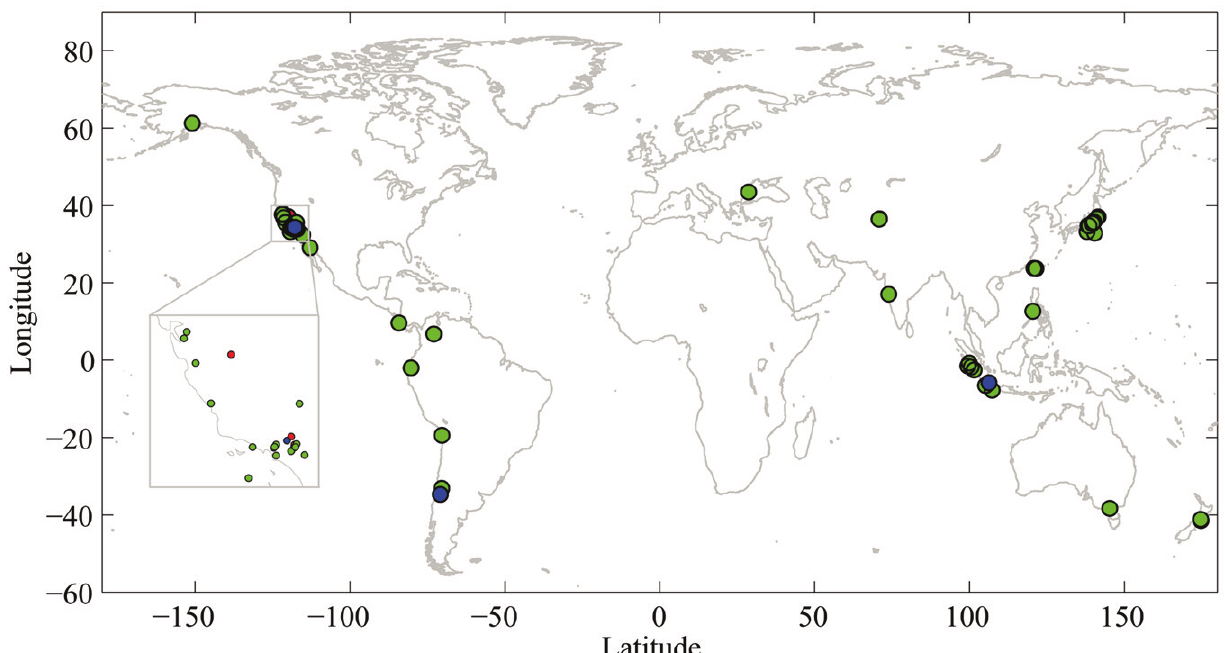
Figure 4. Map showing events caught by our detector using the ‘moderate’ threshold. Green dots, ‘verified’ earthquakes; blue dots, ‘possible’ earthquakes; red dots, ‘false’ triggers. The inset map shows an expanded view of California where the two false triggers occurred.